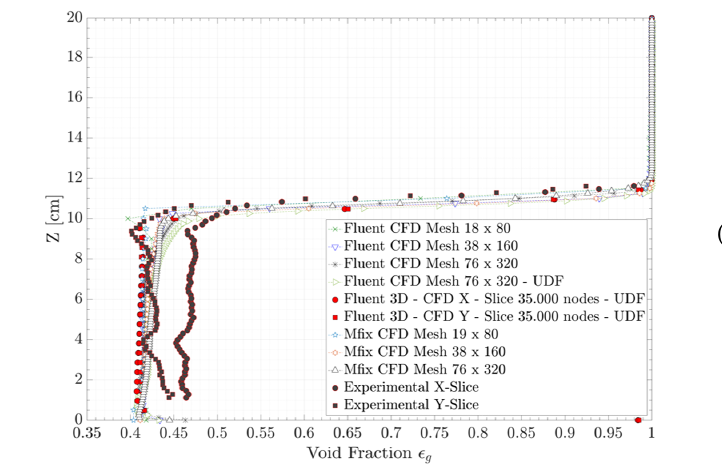
Figure 6. Averaged void fraction profiles as function of column diameter at ( a ) 4 cm and ( b ) 8 cm above flow distribution plate; ( c ) function of column height (calculated as mean values of all grids at the same height). Comparison between experimental and numerical data averaged between 5 s and 40 s.